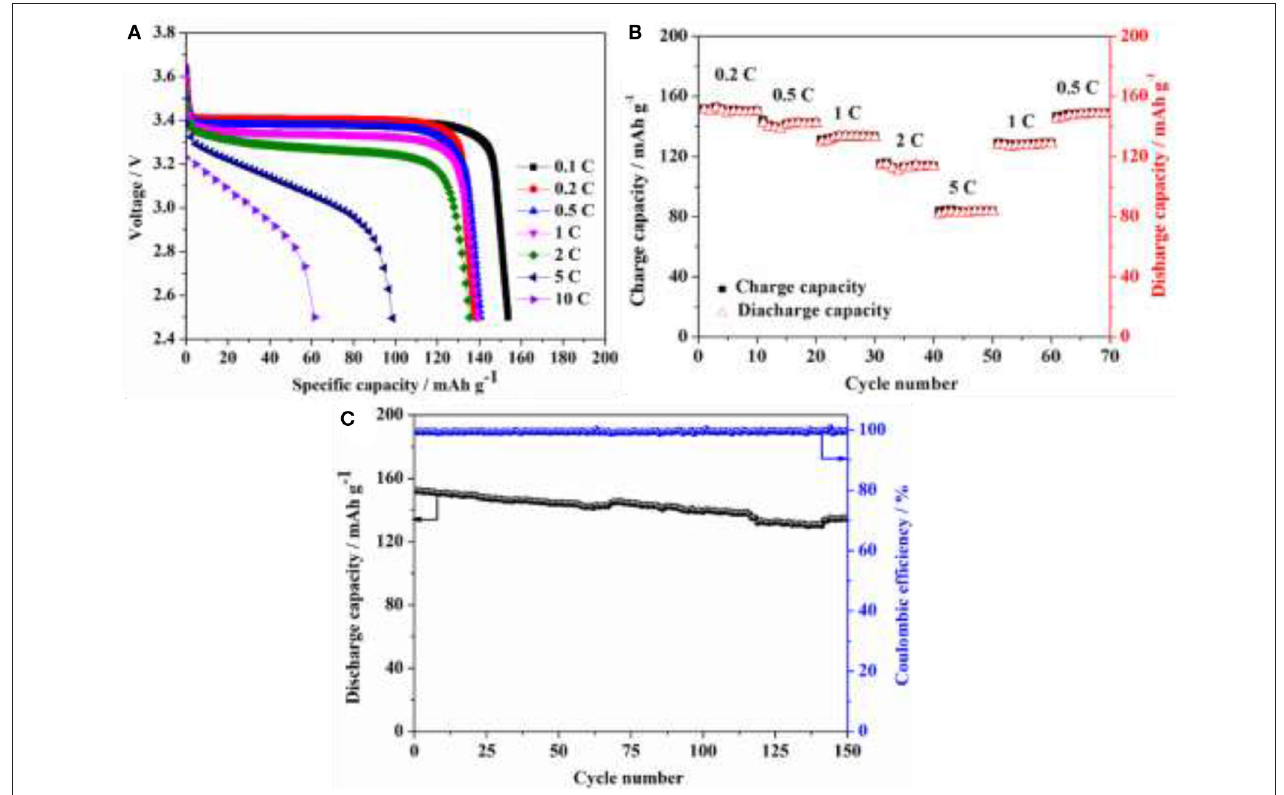
FIGURE 8 | (A) Discharge curves for LiFePO 4 /Li battery assembled using HPEs with 5% POSS content under various C-rates with a charge current density of 0.1C at 80 ◦ C; (B) Charge and discharge performance of LiFePO 4 /Li battery assembled using HPEs with 5% POSS content under different circulatory rates at 80 ◦ C; (C) Cycling performance of LiFePO 4 /Li battery assembled using HPEs with 5% POSS content with a current density of 0.5C at 80 ◦ C.